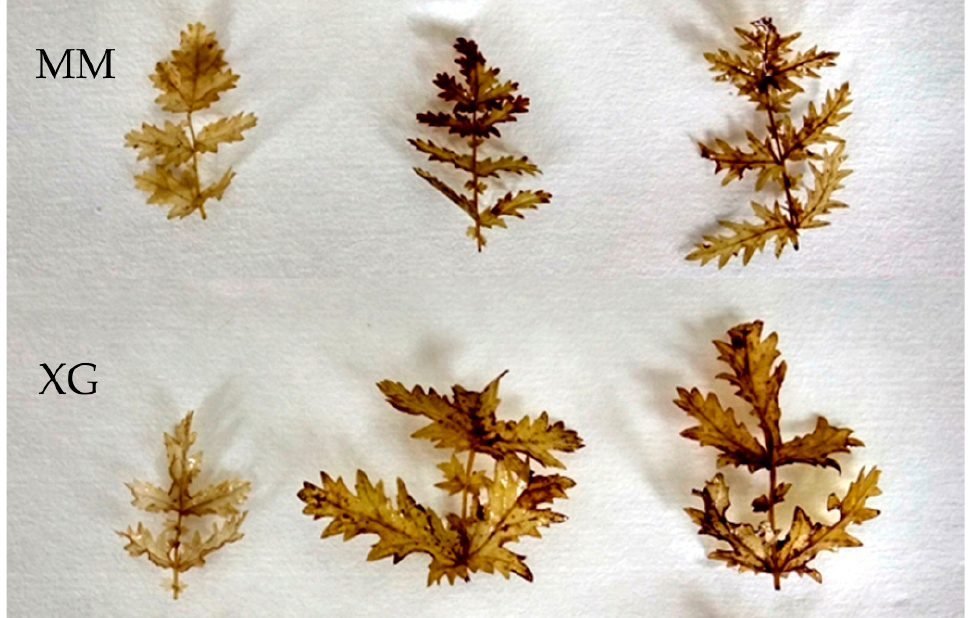
Figure 7. Occurrence of hydrogen peroxide (dark, brown color) in the stem leaves of Filipendula vulgaris Moench collected from the areas of Molinia meadows (MM) and xerothermic grasslands (XG) (photo: K. Mo ż d ż e ń ).